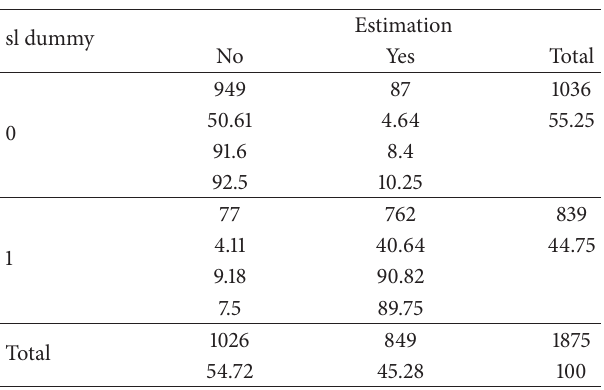
Table 6: Sampling level dummy by estimation.